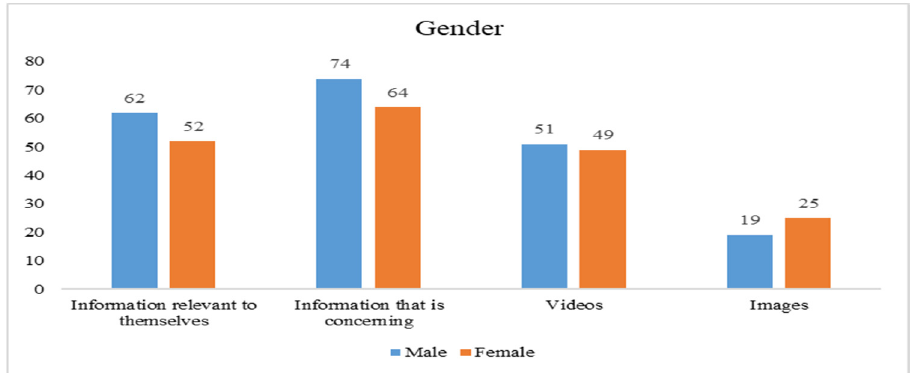
Figure 2. Gender distribution of the study respondents.